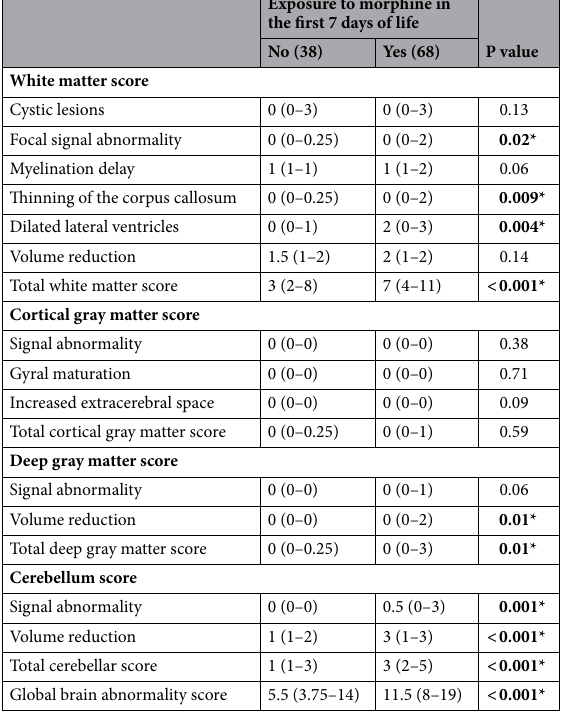
Table 2. Univariate analysis of global brain abnormalities score on TEA-MRI in relation to morphine exposure in first week of life (n = 106). Data are presented as median (IQR), or number (%), as appropriate. Significant values are in bold. *Statistically significant at 5% level.